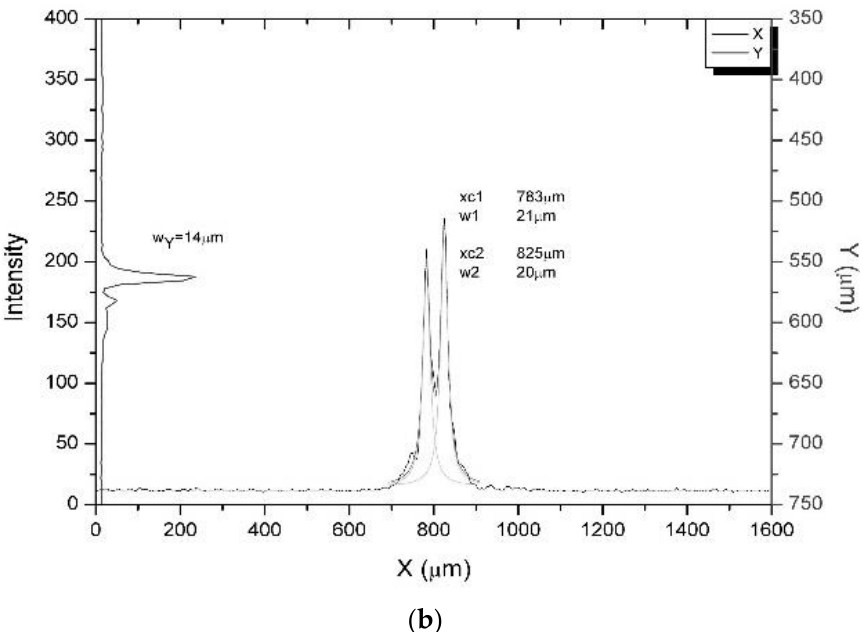
Figure 10. ( a ) Near-field beam profile and ( b ) mode cross-section for TE modes propagating at 1064 nm in 20 μ m lithium niobate channel waveguides on lithium tantalate samples obtained by imaging with a 10× microscope objective. (Spiricon, Logan, UT, USA).